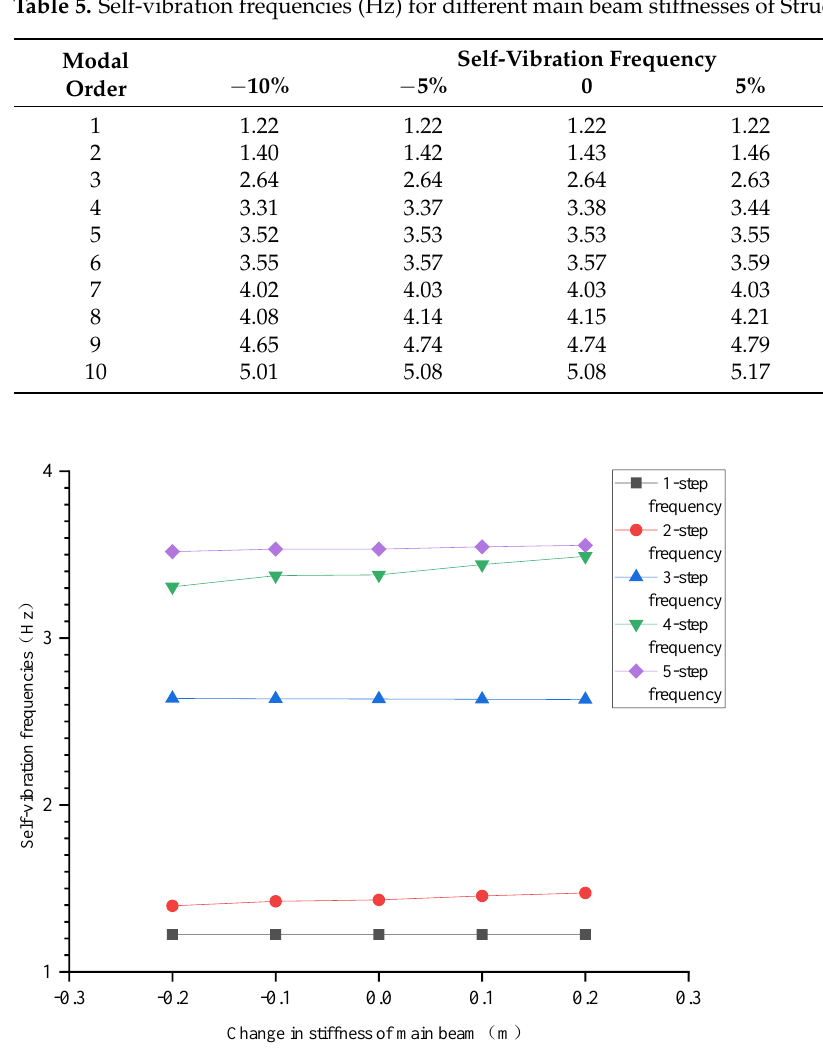
Figure 9. Self-vibration frequencies for different main beam stiffnesses of Structure I. The effect of the stiffness changes of the main beam of Structure I is similar to that of the original structure, with the first-order vertical self-vibration frequency increasing by 5.59% when the stiffness of the main beam is increased from −1 0% to 10%. This indicates that the increase in the stiffness of the main beam has a greater effect on the vertical stiff- ness of Structure 1 compared to the original structure. Table 6. Self-vibration frequencies (Hz) for different main beam stiffnesses of Structure II. Modal